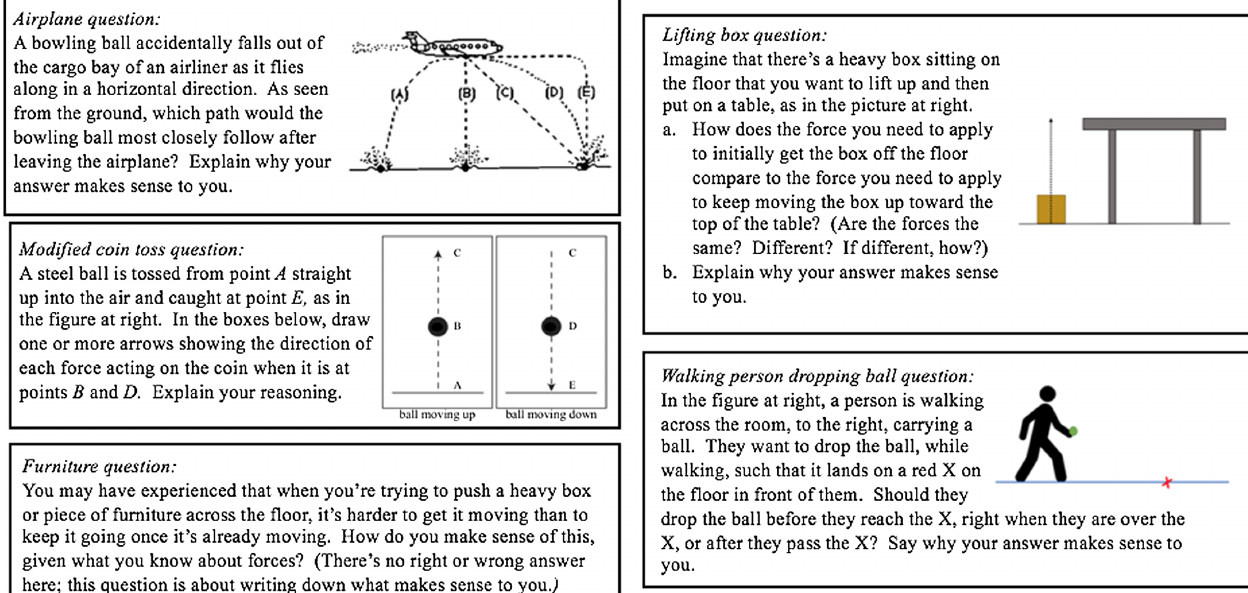
FIG. 2. Conceptual questions used in forces study. From Hestenes, Wells, and Swackhamer